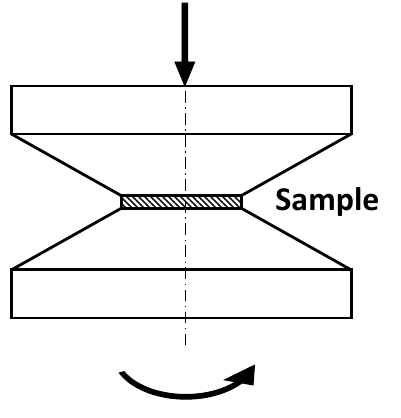
Figure 1. Scheme of high pressure torsion straining.